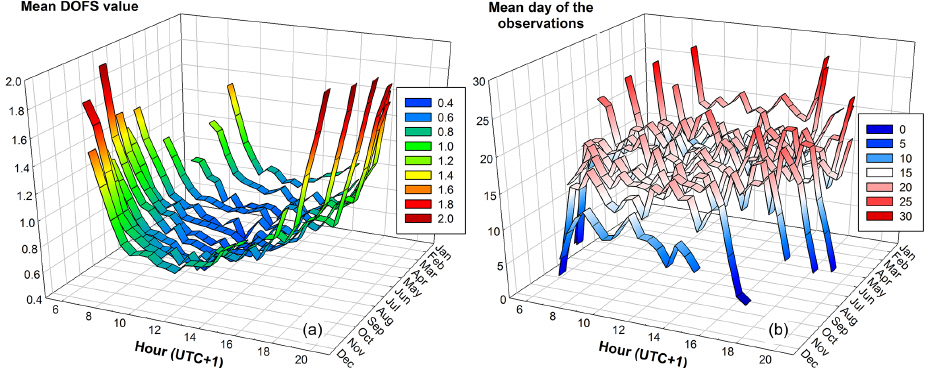
Figure 2. Average of the mean DOFS values and the mean observational day of the month ( a and b , respectively) of all individual observations made by the Bruker instrument between January 1995 and June 2015 at the ISSJ, according to the hour of the day and for each month of the year. The average has been calculated with a time step and an integration length of 0.5h (no smoothing has been applied here).